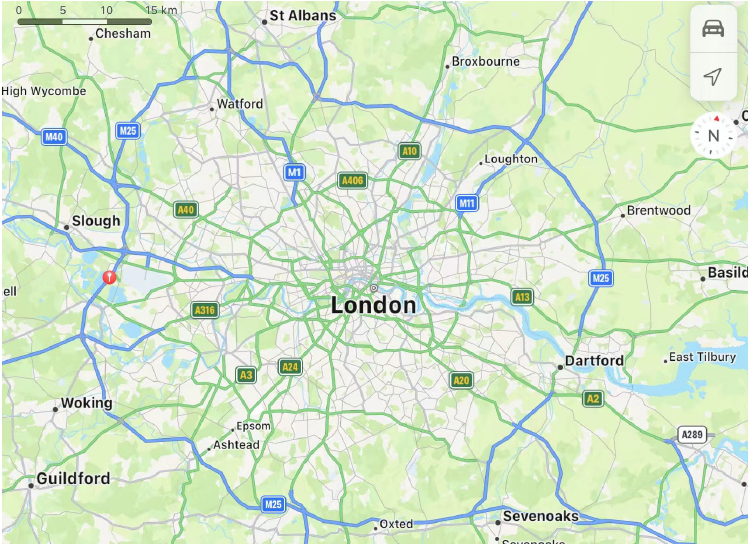
Figure 2. Maps of the selected detector locations on the M25 motorway in London, where the big red pin indicates the detector.